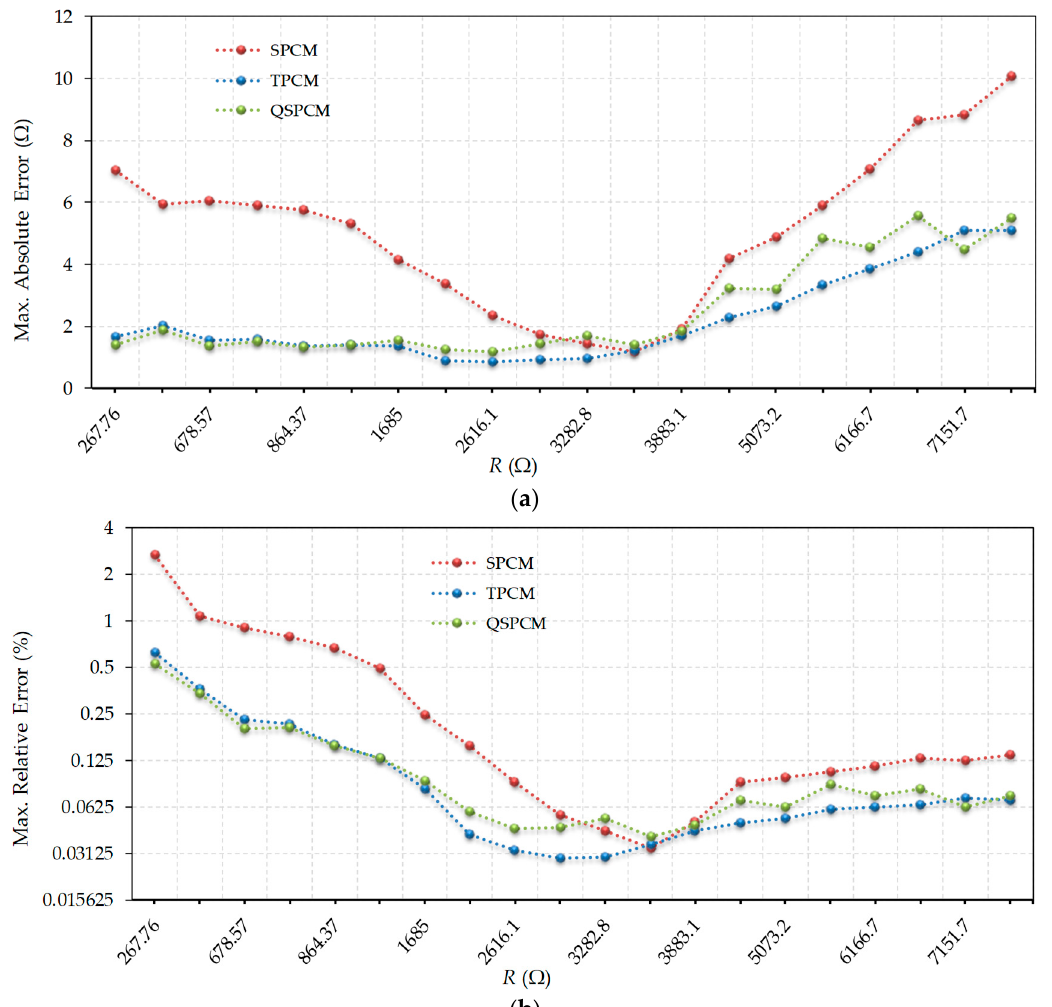
Figure 2. Errors in estimating resistance values using SPCM, TPCM, and QSPCM: ( a ) absolute maximum errors (linear scale); ( b ) relative maximum errors (log2 scale).